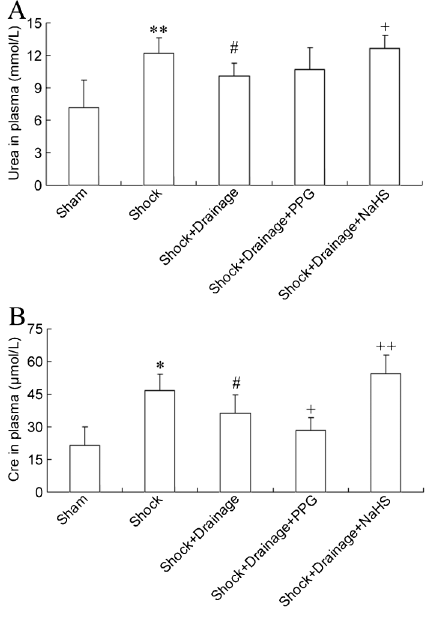
Figure 3. Changes in biochemical indices of renal function in rats. A , Urea in plasma; B , Creatinine (Cre) in plasma. Data are reported as means±SD (n=6). PPG: D,L-propargylglycine; NaHS: sodium hydrosulfide hydrate. *P , 0.05, **P , 0.01 vs the sham group; # P , 0.05 vs the shock group; + P , 0.05, ++ P , 0.01 vs the shock++drainage group (one-way